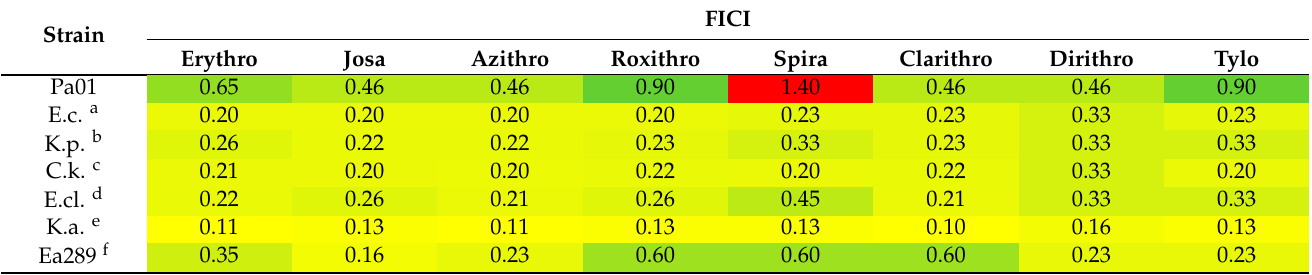
Table 5. Fractional Inhibitory Concentration Index (FICI) obtained for interactions of compound 3 with eight different macrolides against various Gram-negative bacteria and classified as follows: FICI ≤ 0.5 = synergistic (yellow); 0.6 < FICI ≤ 0.9 = additive (green); and 1 < FICI ≤ 3.9 = indifferent (red). The variation of the color from yellow to green is related to the importance of the synergy (from higher to lower